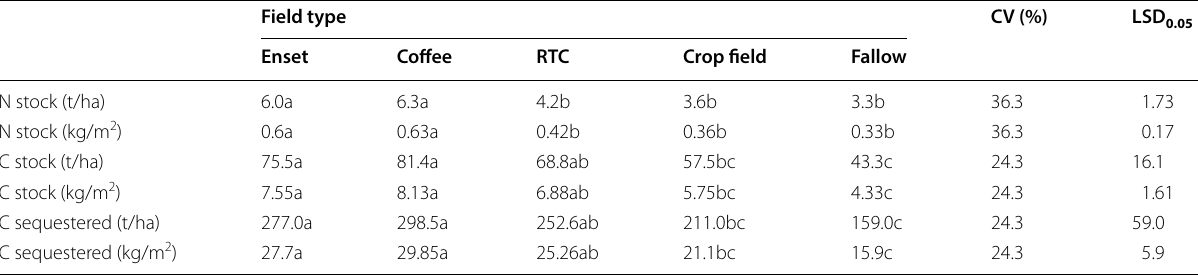
Table 3 N and C Stock, and C sequestered under fields in the